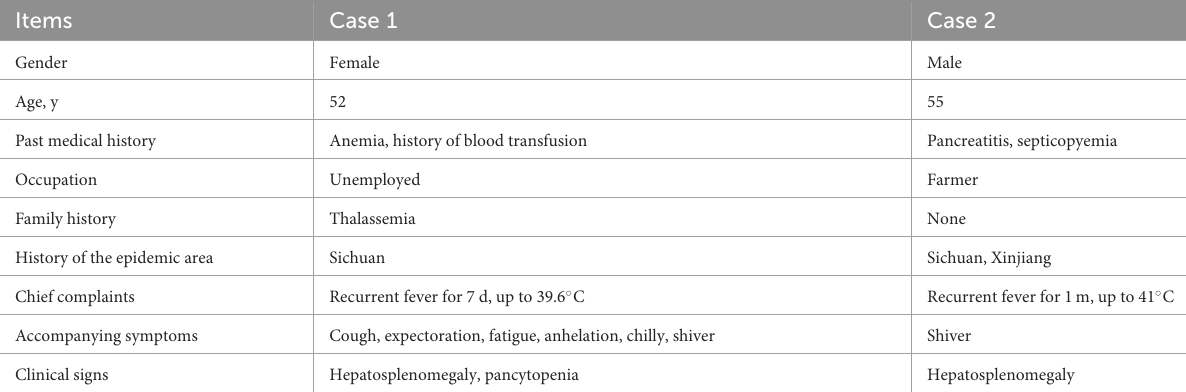
TABLE 1 Demographics and clinical presentations of the 2